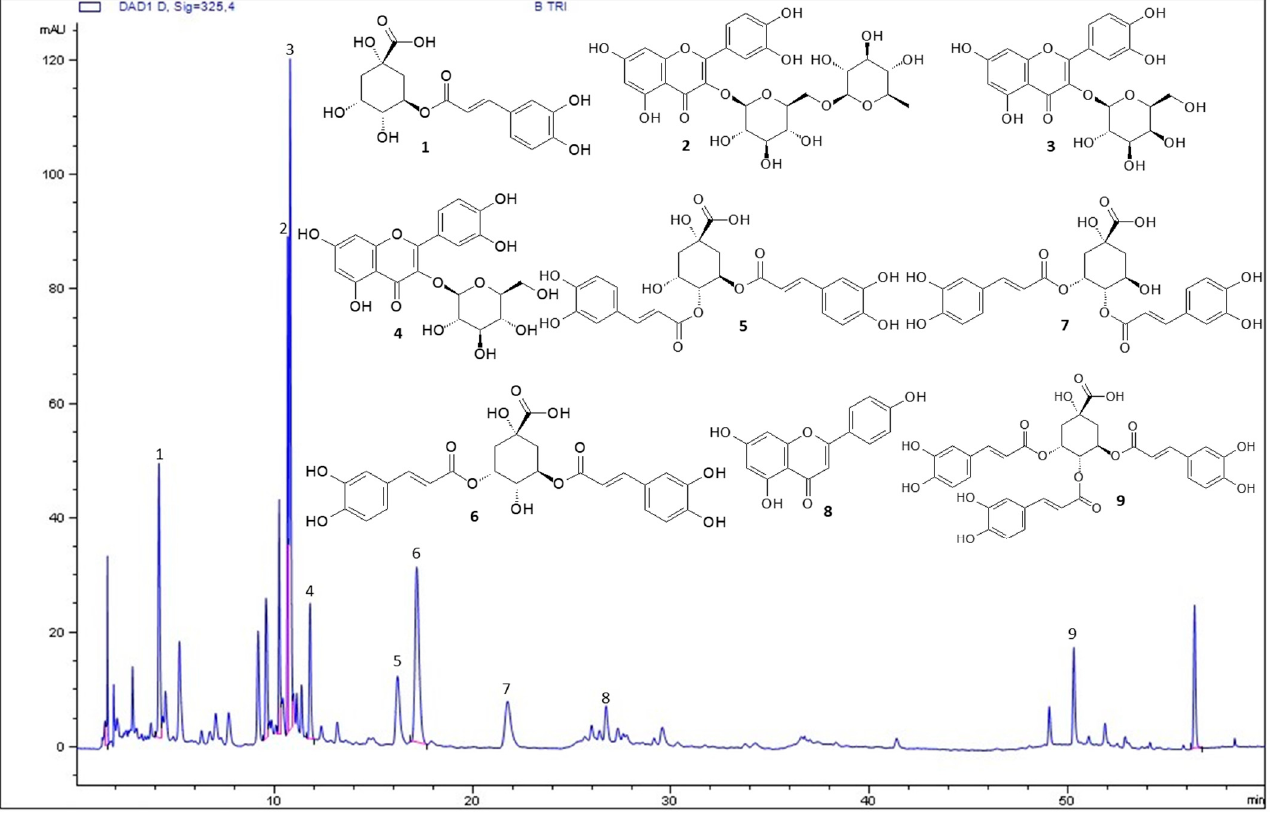
Figure 1. Chromatogram of Baccharis trimera leaf extract (BT) obtained from HPLC-UV-DAD. (1) 5-caffeoylquinic acid; (2) rutin; (3) hyperoside; (4) isoquercetin; (5) 4,5-dicaffeoylquinic acid; (6) 3,5-dicaffeoylquinic acid; (7) 3,4-dicaffeoylquinic acid; (8) apigenin; (9) 3,4,5-tricaffeoylquinic acid. The other peaks of the chromatogram were not identified, however, these compounds pertain to flavonoid and chlorogenic acid derivatives classes. BT: Baccharis trimera aerial part extract; HPLC-UV-DAD : high-performance liquid chromatography coupled to an ultraviolet spectrum scanning photodiode array detector .